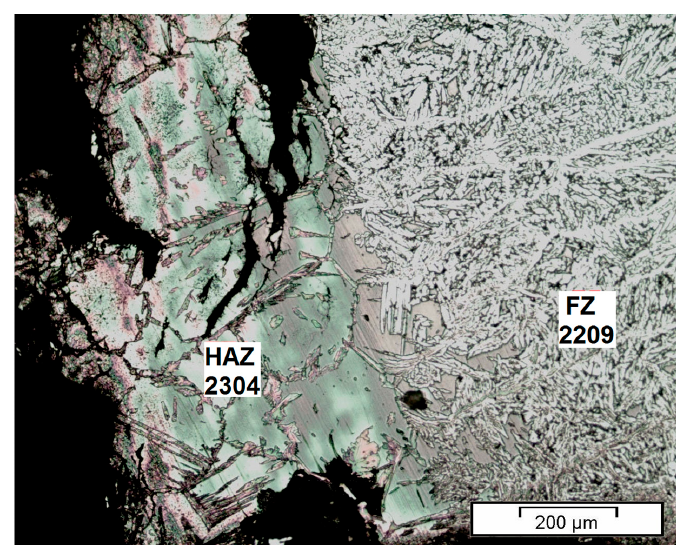
Figure 3. Microstructure of dissimilar weldment with 2209 weld metal showing stress corrosion cracks in the HAZ on the 2304 DSS side.